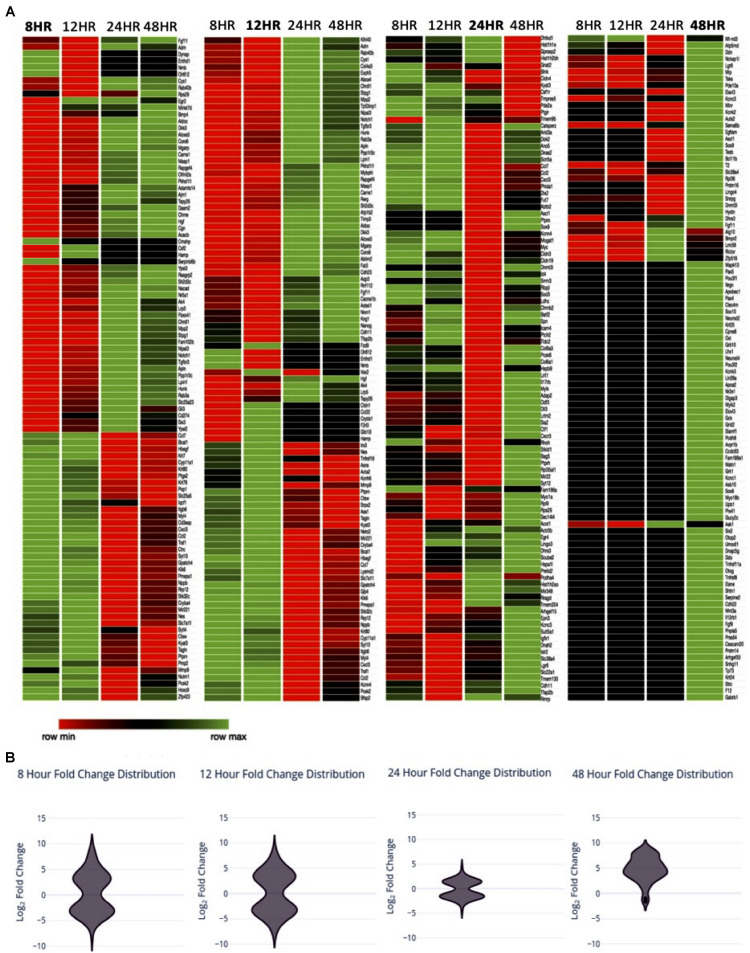
Expression changes over time (A) Heat map with of sDEGs from Müller glia RNA expression changes 8, 12, 24, and 48 h post-exposure to PNU-282987 treated RPE cells, compared to 48-h DMSO control conditions. sDEGs represented include a linear sample of total sDEGs per timepoint. Created using Morpheus. (B) Violin distribution plots of sDEGs per timepoint at the timepoint represented.